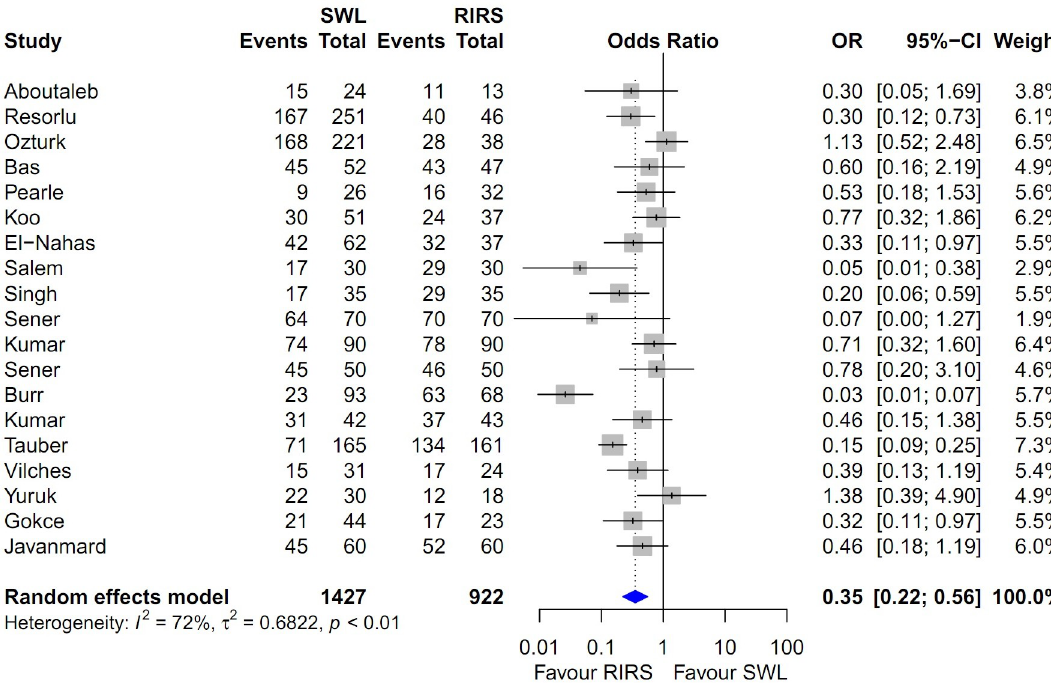
Fig 5. Pairwise meta-analysis of success rate in SWL and RIRS. Results show that the stone-free rate of SWL was lower than RIRS (OR 60.46; 95% CI 0.30–0.71; P < 0.001).